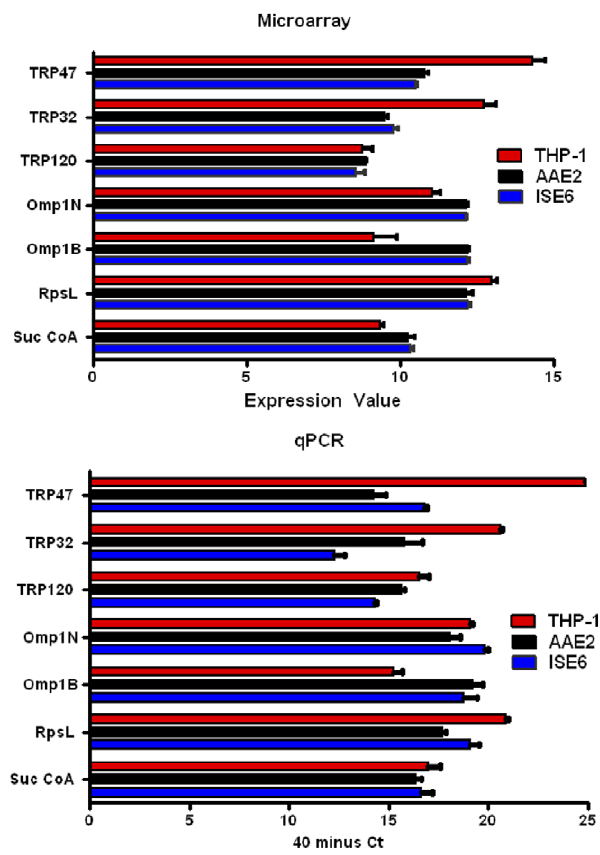
Figure 3. Comparison of microarray (gene expression value) and qPCR (40 minus threshold cycle) analysis of selected E. chaffeensis transcript levels.